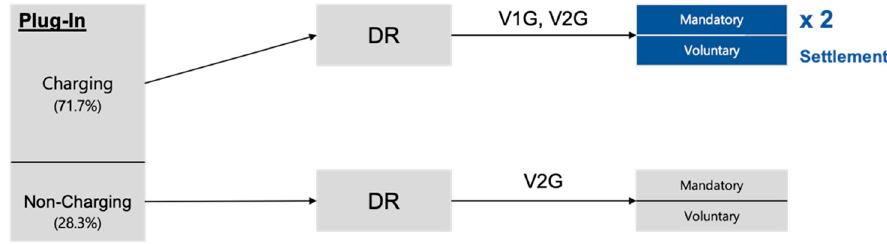
Figure 3. Demand response settlement